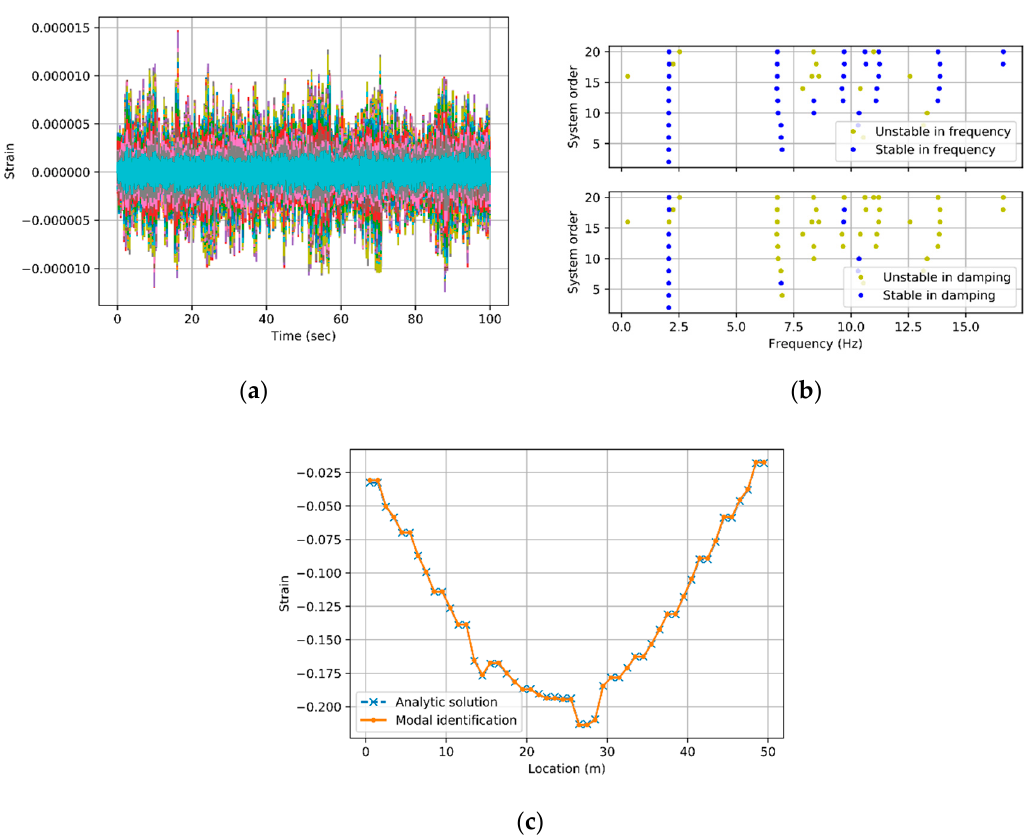
Figure 6. Modal identification: ( a ) measured strains; ( b ) stabilization diagram; and ( c ) mode shape obtained by modal identification.